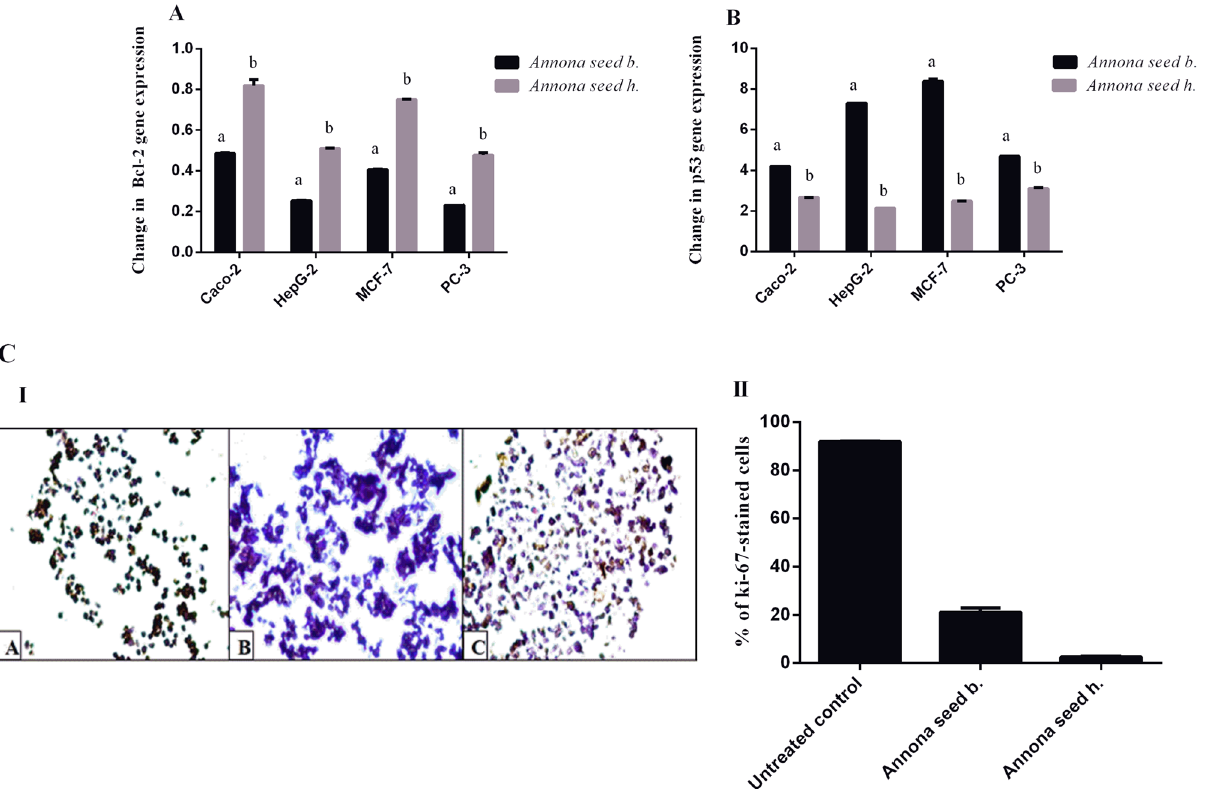
Figure 5. Effect of the studied Annona b. seed extract and Annona h. seed extract on relative gene expression of ( A ) Bcl-2 and ( B ) p53 in different cell lines as well as ( C ) Ki-67 immunostaining in the treated HepG-2 cells illustrated as (I) Microscopic images with (II) Percentage of Ki-67 immunostained cells. Results are presented as mean ± SE (n = 3). Different letters for the same cell line are significantly different at p < 0.05. (CellSens Dimension 1.12; https ://www.olymp us-lifes cienc e.com/en/softw are/cells